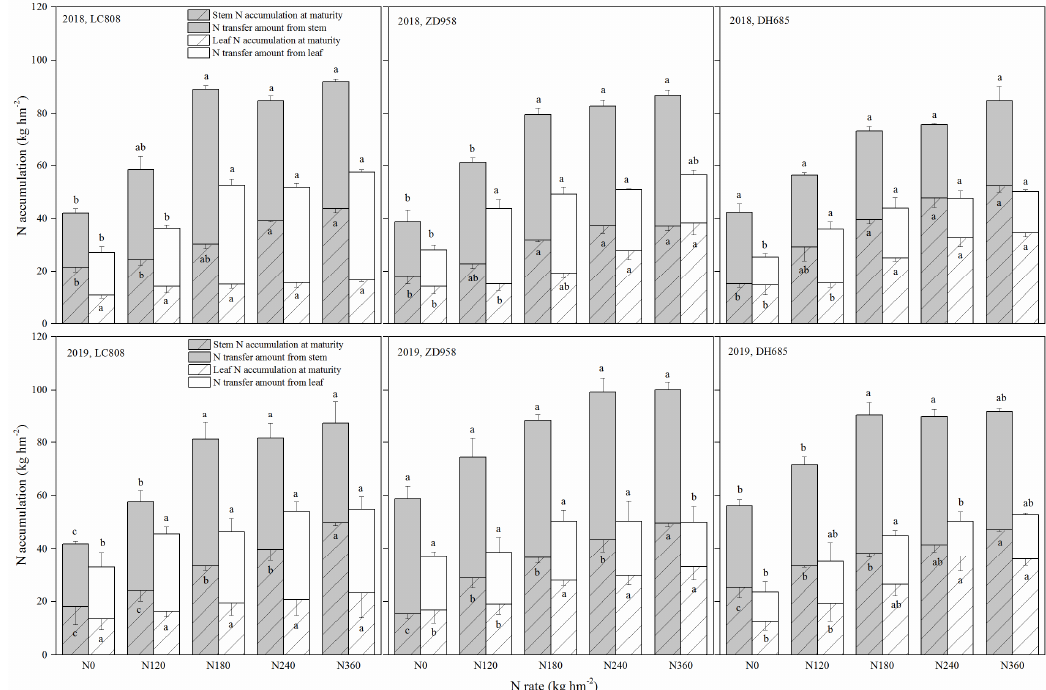
Figure 7. Effects of different N fertilizer application rates on N use efficiencies of different types of Figure 7. E ff ects of di ff erent N fertilizer application rates on N use e ffi ciencies of di ff erent types of stay-green maize. Additional letters represent significant differences ( P < 0.05) in N accumulation or stay-green maize. Additional letters represent significant di ff erences ( p < 0.05) in N accumulation or N N transfer amount for the same organ between the different N rates. Error bars indicate the SD. transfer amount for the same organ between the di ff erent N rates. Error bars indicate the SD.